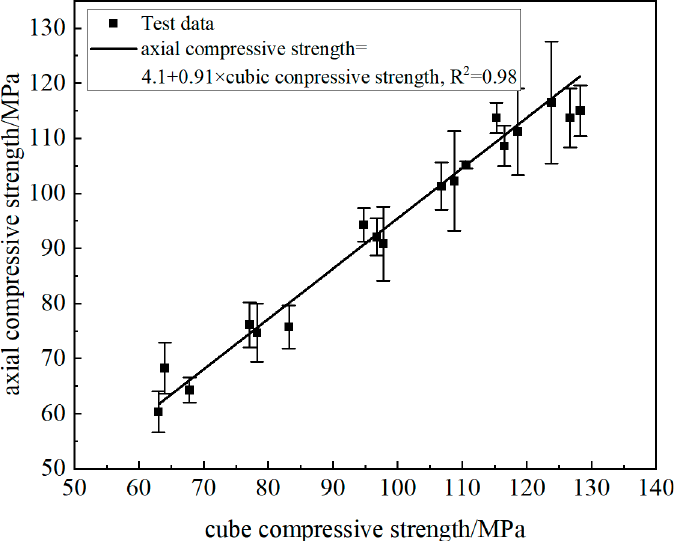
Figure 8. Fitting treatment of axial strength and cubic strength of HSGM.